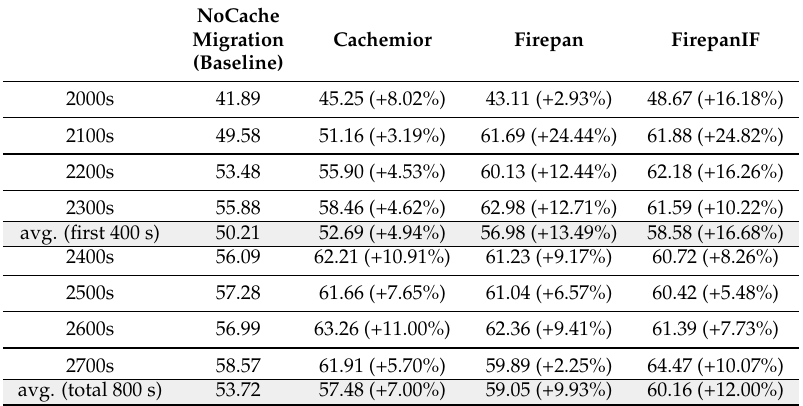
Table 1. Average bandwidth between 400 and 800 s after VM